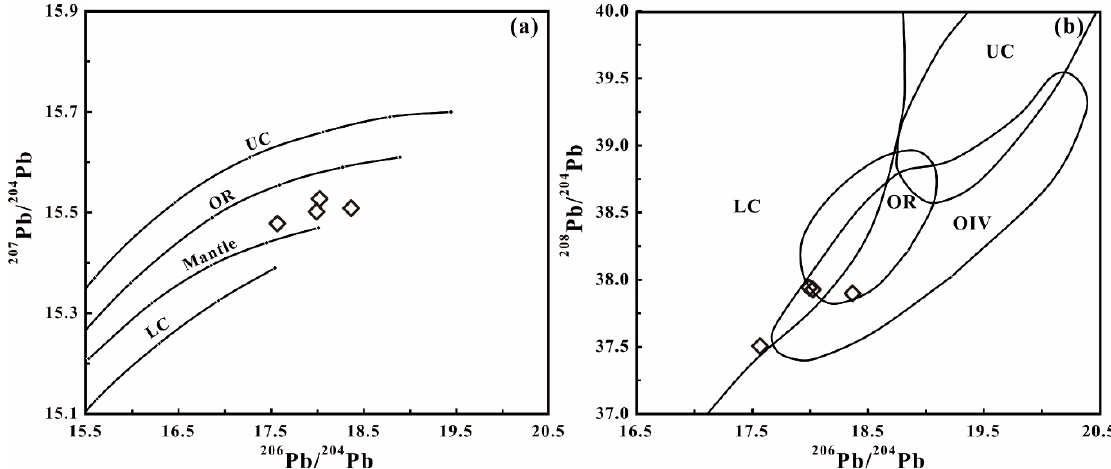
Figure 10. 207 Pb / 204 Pb vs. 206 Pb / 204 Pb ( a ) and 208 Pb / 204 Pb vs. 206 Pb / 204 Pb ( b ) diagrams of the Wulandele MG with Pb isotopic evolution curves (after [29]). UC—Upper Crust; LC—Lower Crust (both continental crust); OR—Orogenic Belt; OIV—Oceanic Island Volcanic.